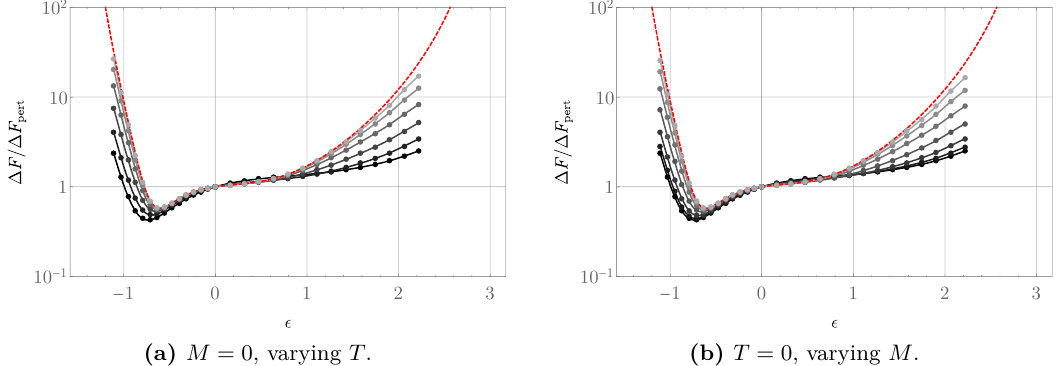
Figure 6. The ratio ∆ F/ ∆ F pert at various temperatures and masses for the Dirac fermion on the deformed spheres given by (4.9), for the representative case ‘ = 2 . In both figures, the black curves correspond to the massless, zero-temperature result, while the dashed red line is the long- wavelength behavior given by (4.18). From black to light gray, the left figure shows tempera- tures T = 0 , 0 . 5 , 1 , 2 , 4 , and 8 , while the right figure shows masses M = 0 , 0 . 5 , 1 , 2 , 4 , 8 and 16 (points are numerical data; the curves are drawn to guide the eye). The range of the x -axis goes from (cid:15) min to (cid:15) max ; the data shown here takes | (cid:15) | sufficiently small that the numerical error in ∆ F is no greater than one